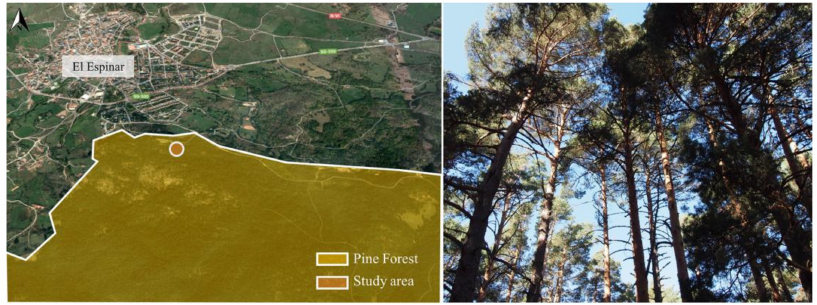
Figure 4. Delimitation of the second test site located in El Espinar (Spain) and a picture of the pines under study. Location: 40 ◦ 42 (cid:48) 33.64 (cid:48)(cid:48) N 4 ◦ 14 (cid:48) 15.70 (cid:48)(cid:48)